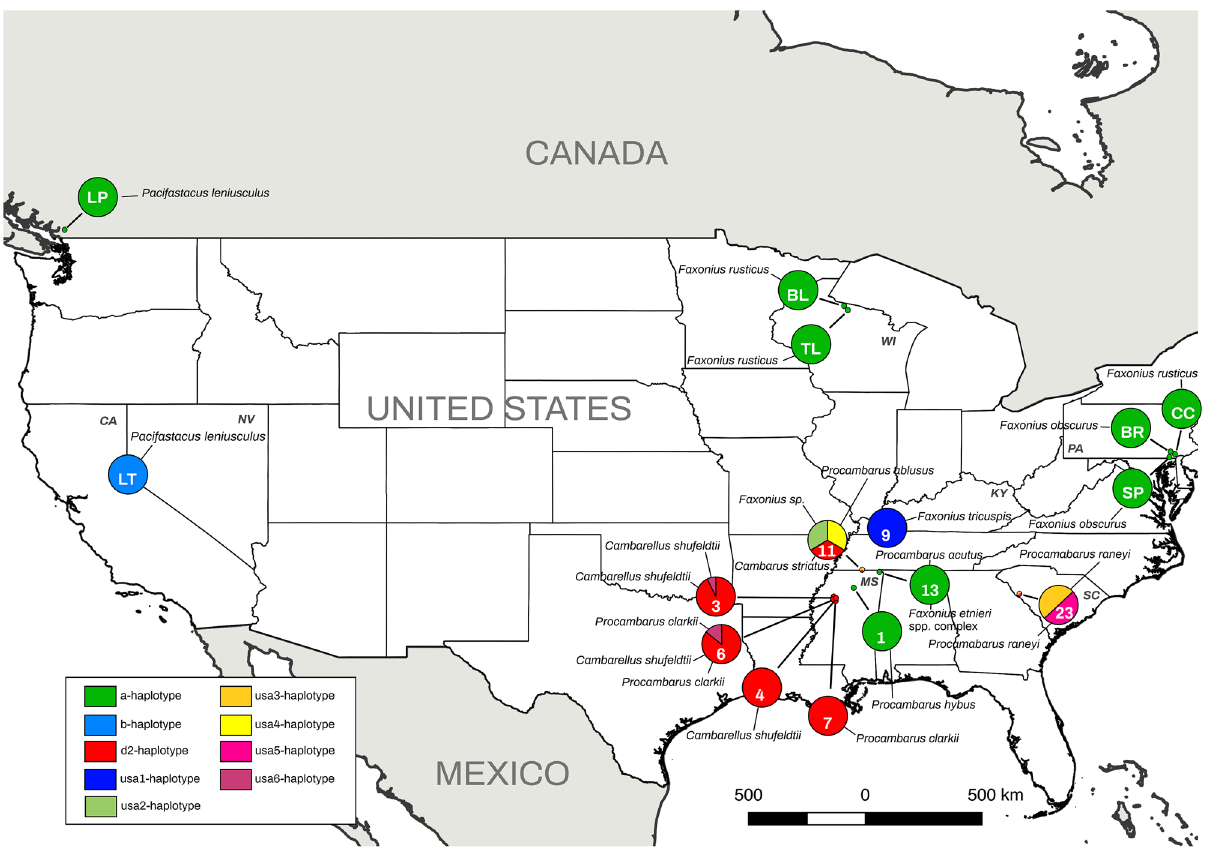
Figure 3. Aphanomyces astaci haplotypes detected from locations (numbers on pie graphs indicate locations; see Table 1) in North America. Haplotype frequencies indicated by relative proportion of the pie graph. Each color of the legend represents a different haplotype based on concatenated mitochondrial rnnS and rnnL regions. Crayfish species hosting different haplotypes are indicated at each location (also in Table 1). Location code LP corresponds to Lake Pitt 50 , LT to Lake Tahoe 63 , BL to Big Lake 62 , TL to Trout Lake 62 , CC to Chickies Creek 64 , BR to Brubaker Run 64 and SP to Sunfish Pond 64 . Two-letter State code is provided with the following abbreviation: CA (California) KY (Kentucky), MS (Mississipi), PA (Pennsylvania), NV (Nevada), SC (South Carolina) and WI (Wisconsin). [Maps were prepared using QGIS 2.14 (https:// www. qgis. org/ en/